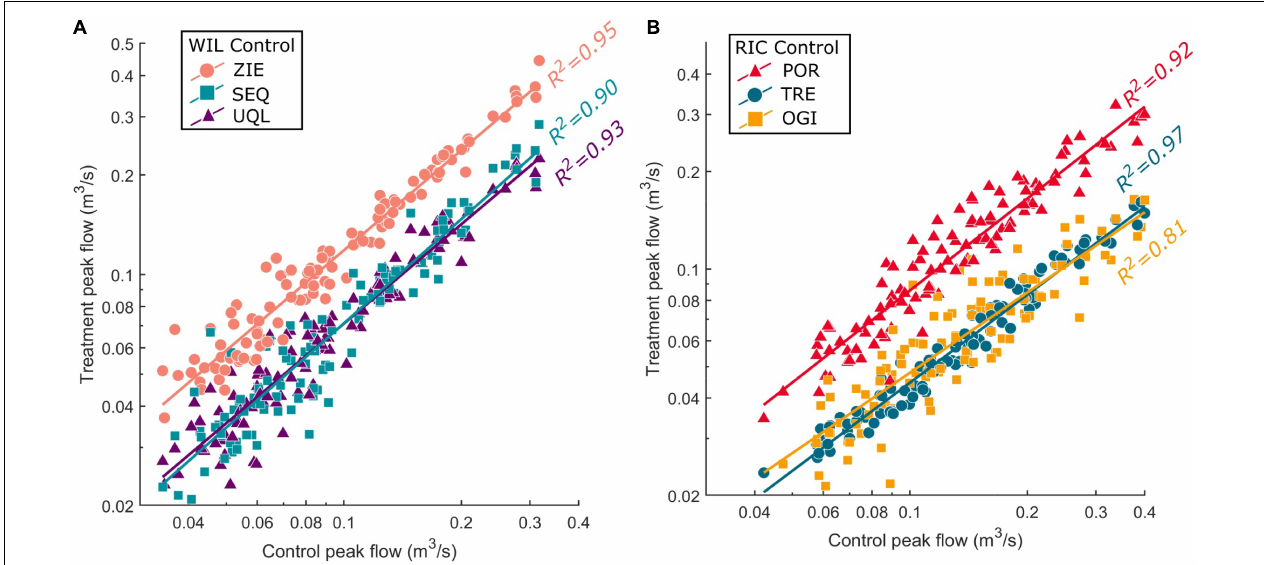
FIGURE 4 | Peak flow calibration period relationships between (A) the treatment sub-watersheds ZIE, SEQ, and UQL and the control sub-watershed WIL and (B) the treatment sub-watersheds POR, TRE, and OGI and the control sub-watershed RIC. For storms with multiple peaks, the peaks were chronologically matched across stations and the highest peak at the majority of stations was identified as the peak flow. Peak flows below 0.02 m 3 /s were excluded from the analysis and the data were log transformed. The best-fit line from ordinary least squares regression analysis of the log-transformed data for each control-treatment pair is shown, and the corresponding R 2 value is listed next to the regression line. Regression equation coefficients are included in Supplementary Table 2 .